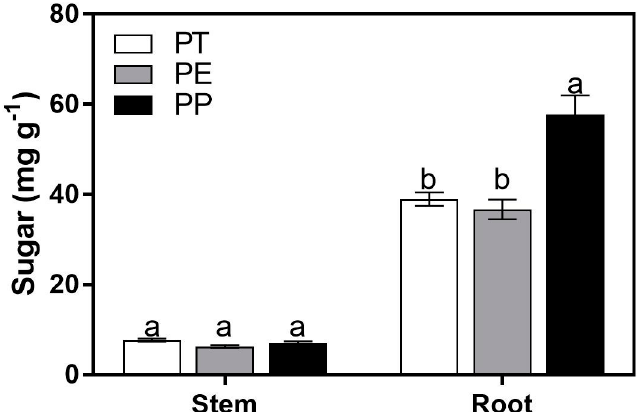
Figure 1. Mean (±standard error (SE)) sugar concentrations (mg g − 1 ) for species (PT = Pinus tadea , PE = Pinus elliottii , and PP = Pinus palustris ) by organ (stem and root) averaged across months (October and March). Bars with different letters within an organ indicate significant difference ( α = 0.05).